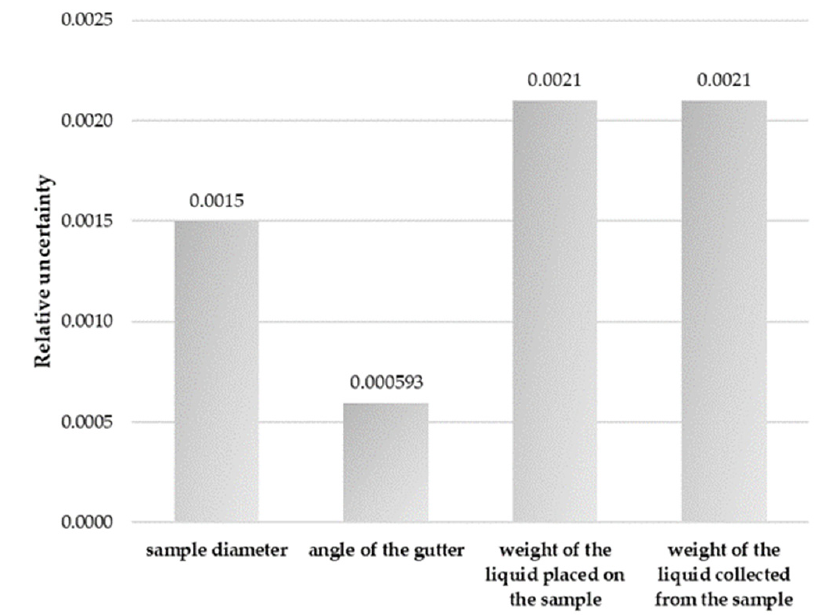
Figure 5. Relative uncertainty of the components of the performed measurements.